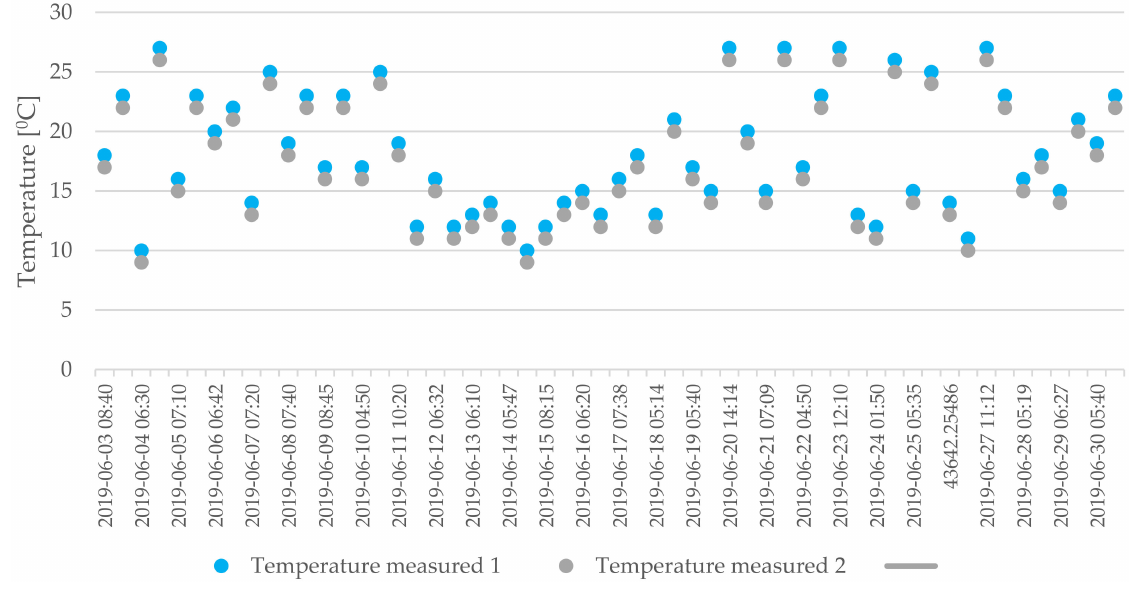
Figure 9. Temperature registration on the shaded part of the